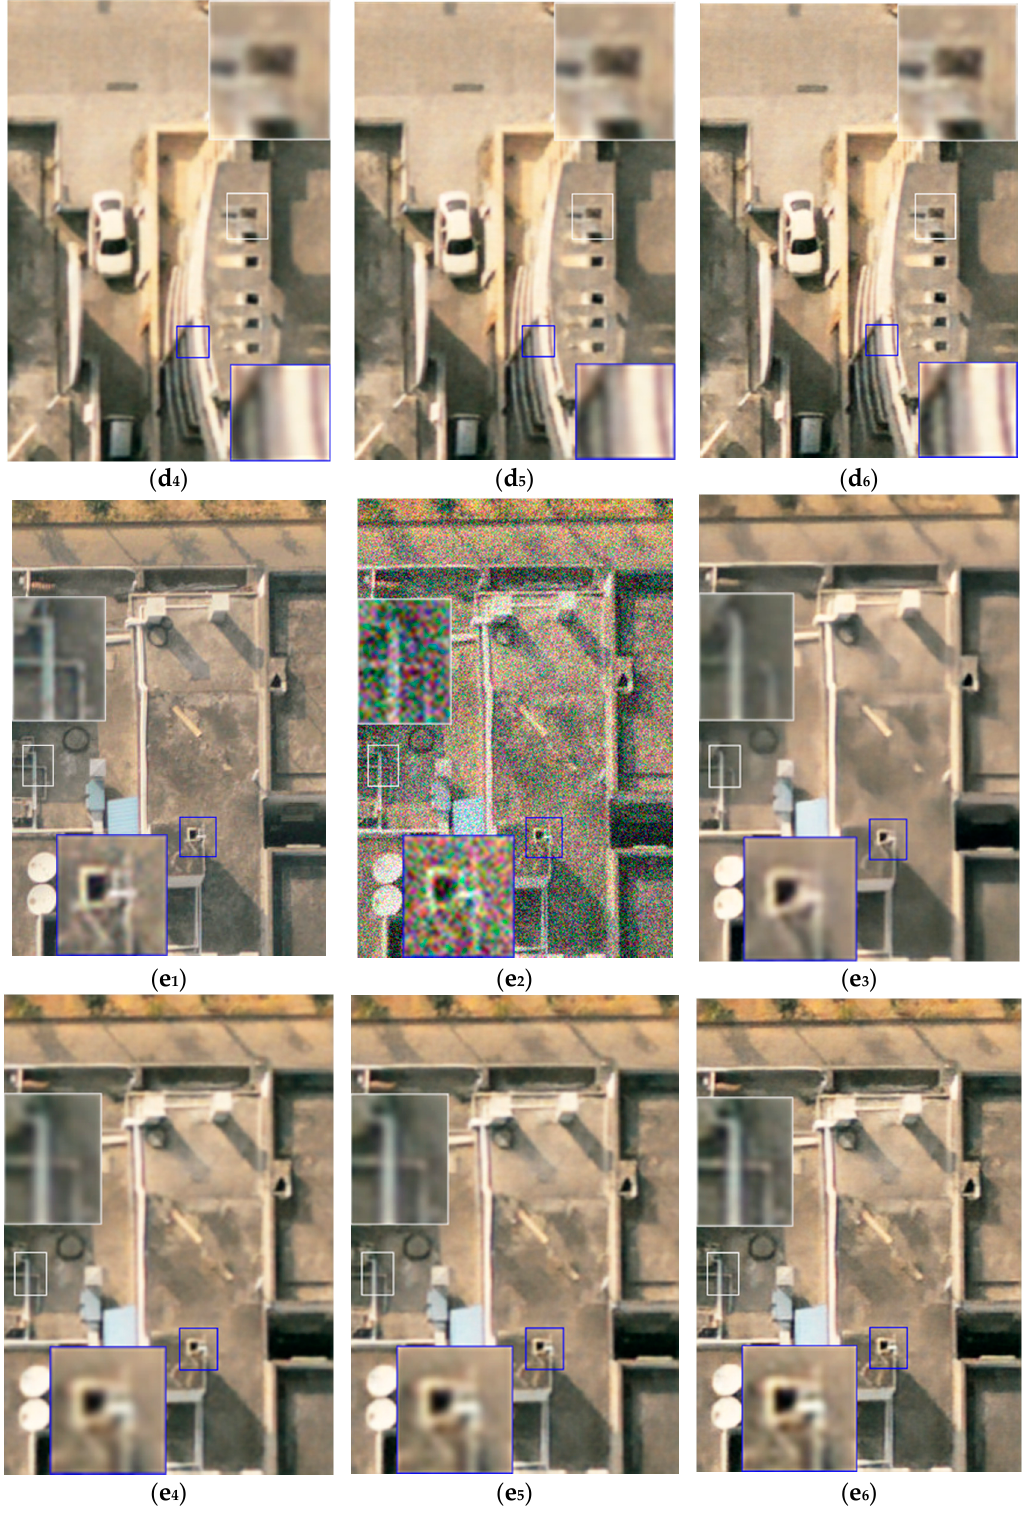
Figure 3. Testing results of several denoising methods for UAV images with several ground objects. In each group of images, the 1st image ( a 1 , b 1 , c 1 , d 1 , e 1 )is the ground truth; the 2nd image ( a 2 , b 2 , c 2 , d 2 , e 2 ) is a noisy image with noise level 55; and the 3rd image ( a 3 , b 3 , c 3 , d 3 , e 3 ) presents the denoising results of method [8]. The 4th image ( a 4 , b 4 , c 4 , d 4 , e 4 ) presents the denoising results of method [5]; the 5th image ( a 5 , b 5 , c 5 , d 5 , e 5 ) presents the denoising results of method [17]; and the 6th image ( a 6 , b 6 , c 6 , d 6 , e 6 ) presents the denoising results of the proposed method.